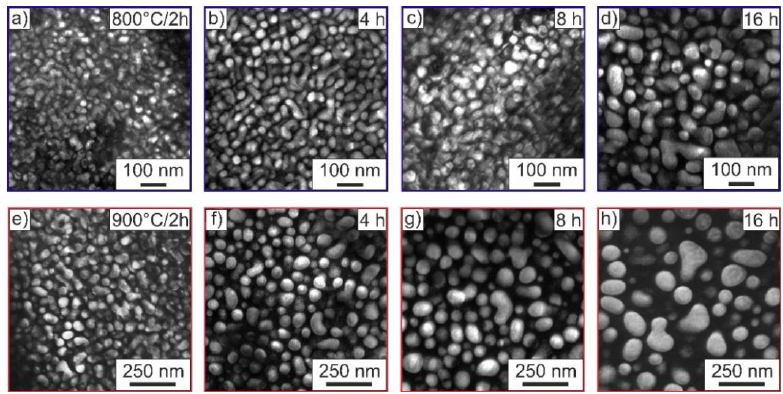
Figure 2. Dark field TEM images of the conditions after aging step I: ( a ) 2 h, ( b ) 4 h, ( c ) 8 h, and ( d ) 16 h at 800 °C; ( e ) 2 h, ( f ) 4 h, ( g ) 8 h, and ( h ) 16 h at 900 °C. The size of the secondary precipitates increased by increasing time and temperature of the annealing heat treatment (see Figure 2 and Table 3). Table 3. Mean radius r of secondary precipitates of the different conditions as determined by TEM.